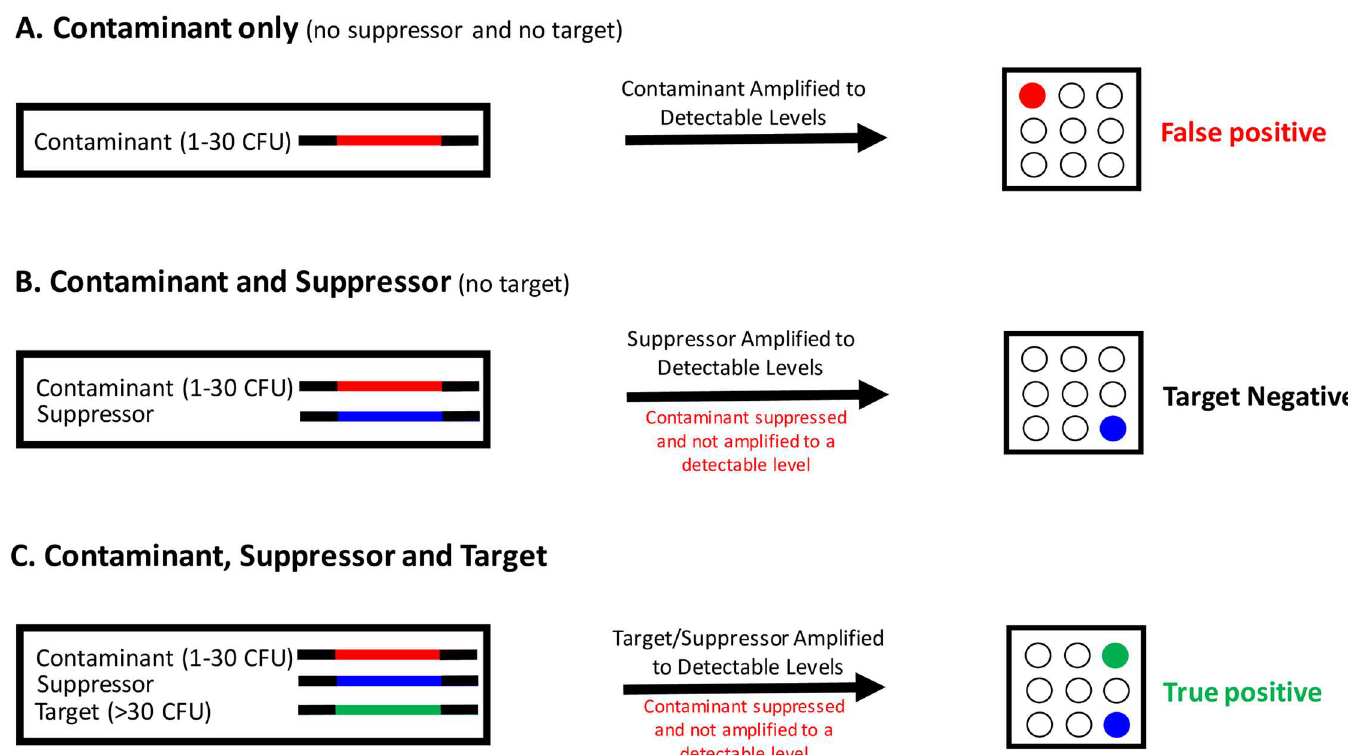
Fig 1. A schematic diagram demonstrating the principle of suppressor eliminating false positive results. A . In the case there is only contaminant in the reaction(no suppressor and no true target), if the contaminating Staphylococcus species level is higherthan LOD, it will be amplifiedand detected on the array as a false positive (red spot). B . If the suppressoris also present in the reaction(but no true target), it will be amplifiedand may optionallybe detected by a suppressor-specific probe on the array (blue spot). At the same time, the amplification of the contaminant is suppressedand will not be amplifiedto a detectablelevel. Therefore, the false positive is eliminated and the result will be negative(as there is no true target). C . In the case whereinthere is also a target truly present in the reaction in addition to the contaminant and suppressor, if the level of the true target input is higherthan LOD, it will be amplifiedand detected on the array as a true positive (green spot) whereas the amplification of the contaminant will be suppresseddue to competitionand will not be amplifiedto a